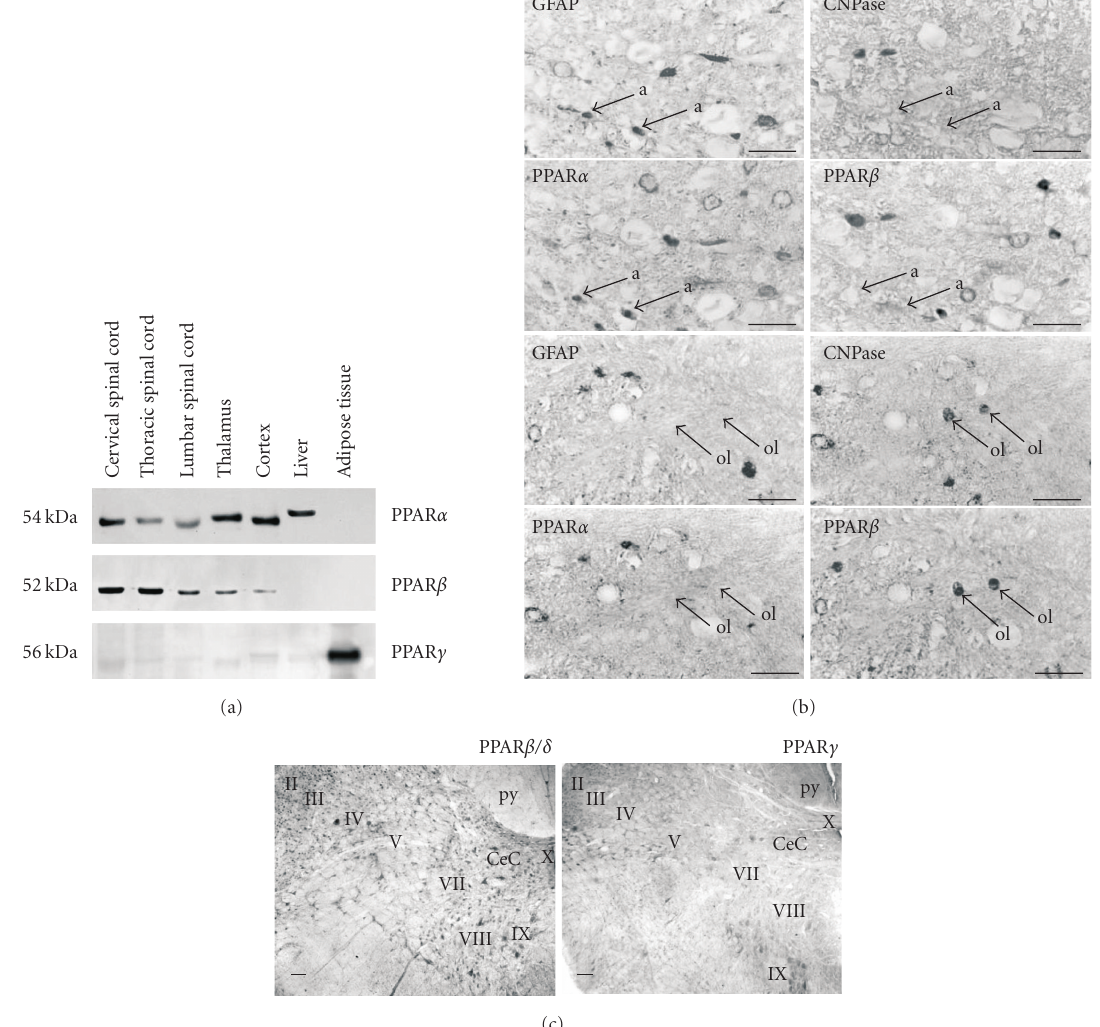
Figure 2: Localization of PPAR α and PPAR β / δ in astrocytes and oligodendrocytes in the spinal cord. (a) Western blotting shows PPAR α and PPAR β but not PPAR γ in spinal cord, telencephalon, and diencephalon. Identical expression patterns were detected with RT-PCR. (b) De- tection of PPAR immunoreactive cells in the white matter of rat spinal cord. GFAP-positive/CNPase-negative astrocytes are immunoreactive for PPAR α (marked a, upper four panels) while GFAP-negative/CNPase-positive oligodendrocytes express PPAR β (marked ol, lower panels) (scale bars: 25 μm , source: [38]). (c) Distribution of PPAR β / δ and PPAR γ immunoreactive cells in the spinal cord of the adult rat (cervical level, coronal sections, scale bar: 100 μm , source: